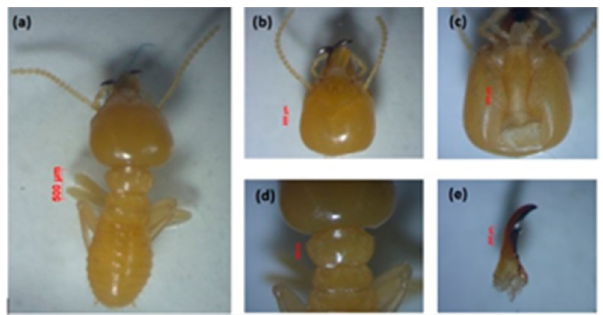
Figure 2. Major soldier of Schedorhinotermes sp.: ( a ) body shape, ( b ) part of the head with antennas, ( c ) postmentum, ( d ) pronotum, and ( e ) left mandible.